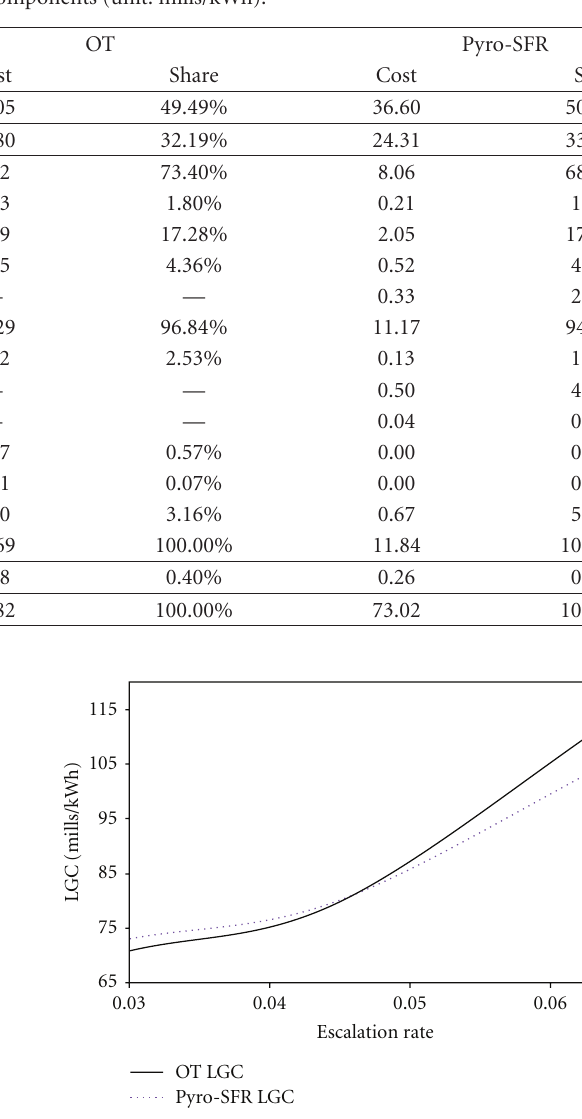
Figure 12: Uranium price model with a discount rate of 5% applied.